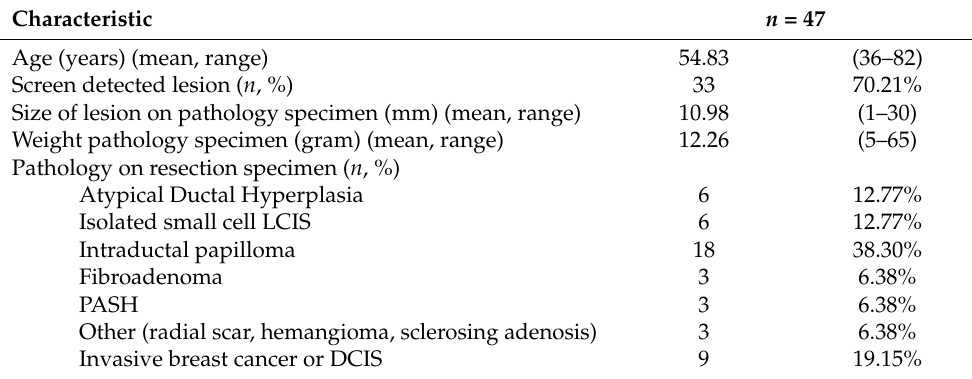
Table 2. Baseline characteristics of patients with benign or B3 breast lesions on core